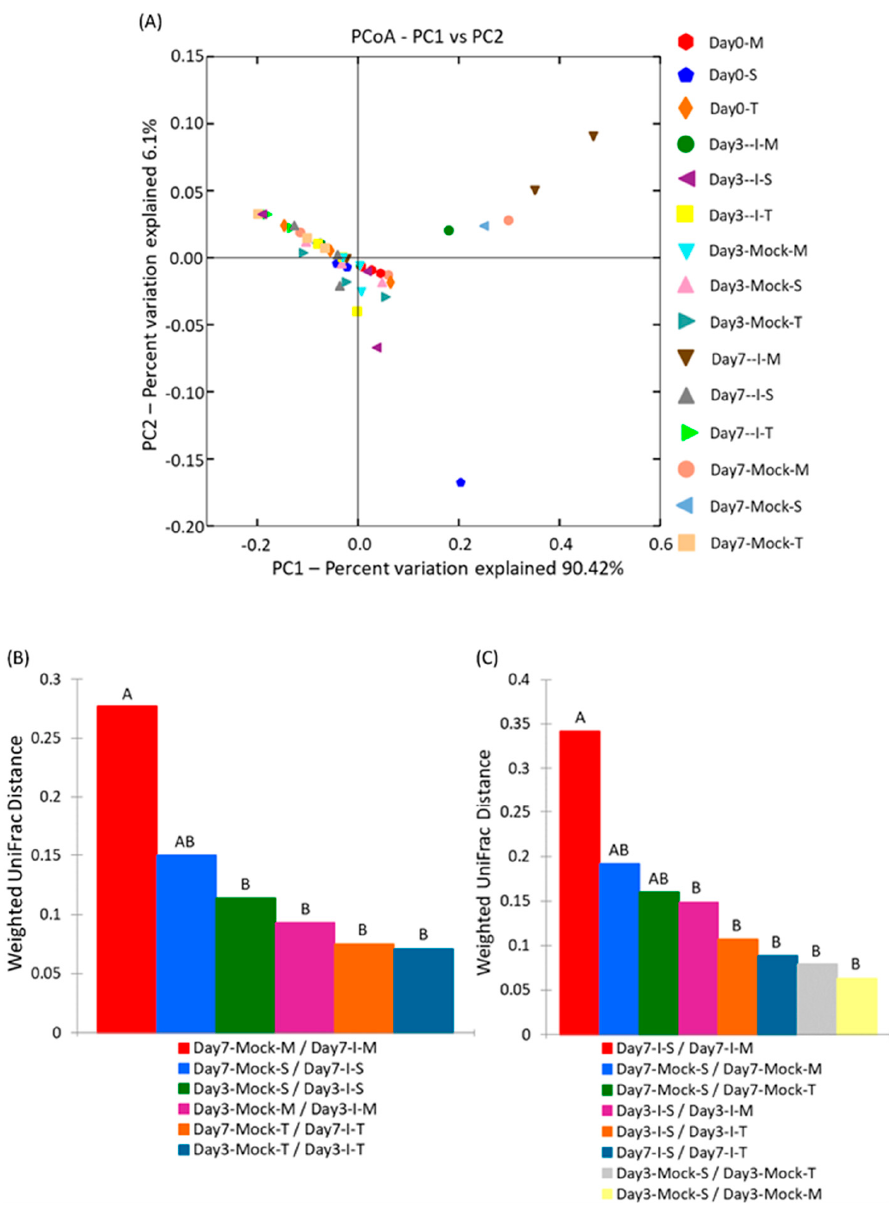
Figure 4. The profile of endophytic bacteria in different samples: ( A ) principal coordinate analysis (PCA), ( B ) comparison of weighted UniFrac distances within each genotype at day 3 and day 7, and ( C ) comparison of weighted UniFrac distances between maize A. flavus -susceptible (S) and -resistant genotypes (T and M) at day 3 and day 7. S: SC212, susceptible genotype; T: TZAR102, resistant genotype; M: MI82, resistant genotype. Mock = mock control and I = A . flavus -infected. Uppercase “A” and “B” above the bars have been used to compare significant difference ( p < 0.05) among treatments. The data are mean ± SE of 3 replicates, and each replicate consists of four